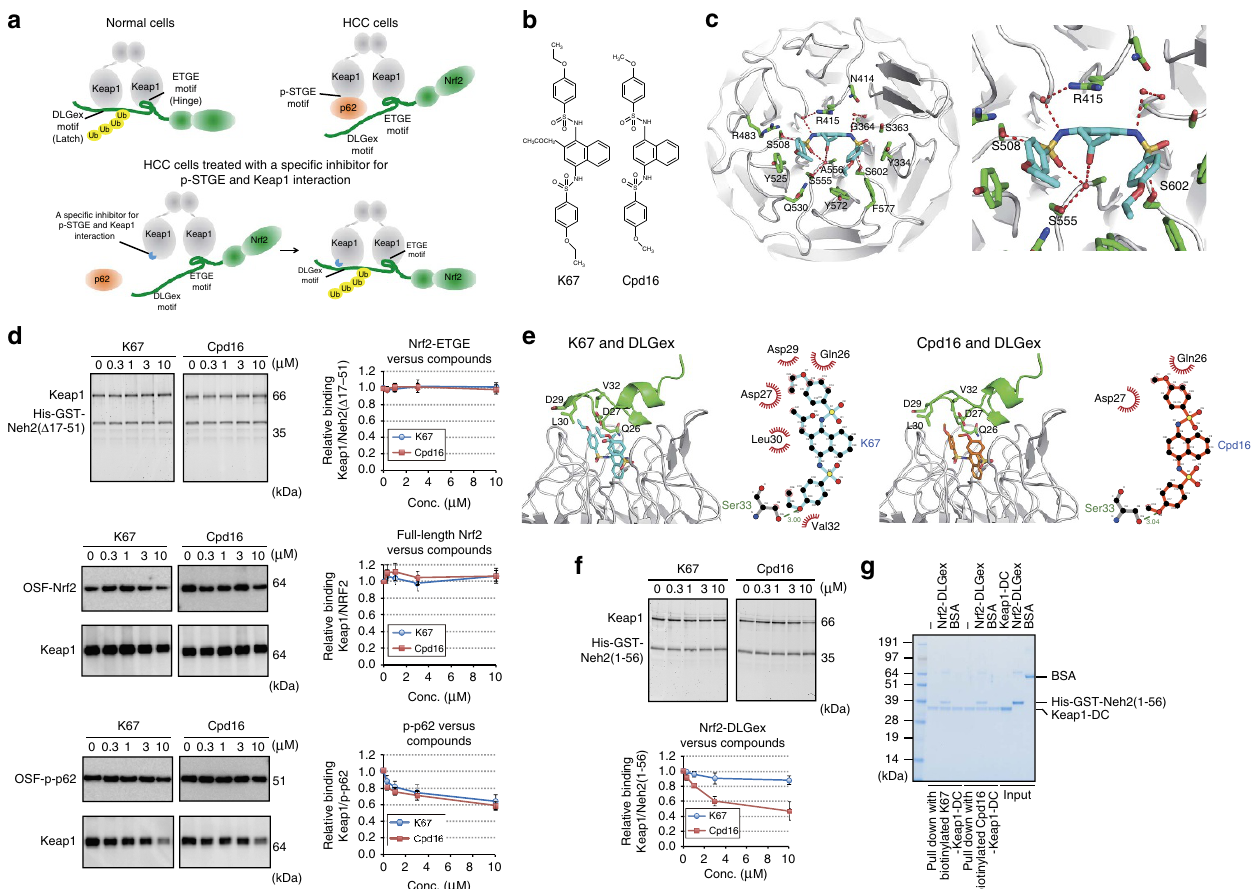
Figure 9 | K67, a chemical compound that inhibits the interaction between Keap1 and S349-phosphorylated p62. ( a ) Working hypothesis about an inhibitors of the interaction between Keap1 and S349-phosphorylated p62. ( b ) Structural formulas of K67 and Cpd16. ( c ) Crystal structure of Keap1-DC (white) in complex with K67 (cyan). Overall structure of Keap1-DC, shown as a ribbon model. K67 (cyan) and some of the potential interacting residues of Keap1-DC are shown in stick representation. A close-up view of K67 bound to Keap1-DC is shown. Intermolecular electrostatic interactions are depicted as broken red lines. ( d ) In vitro pull-down assay. Full-length Keap1 was allowed to form a complex with K67 (left panel) or Cdp16 (right panel) at the indicated concentration. Upper panel: Keap1 binding to His-GST-tagged Neh2( D 17-51) was estimated by Oriole fluorescent gel staining. Middle and bottom panels: Keap1 binding to OSF-p-p62 (middle panel) or OSF-Nrf2 (bottom panel) was estimated by immunoblot analysis with anti-Keap1 antibody. Data are representative of three independent experiments. ( e ) Modelling of Keap1 (white)–K67 (cyan)–DLGex (green; upper left panel) and Keap1–Cpd16 (orange)– DLGex (lower left panel). Upper right: schematic representation of the interface between DLGex and K67. Lower right: schematic representation of the interface between DLGex and Cpd16. Potential hydrogen bonds are indicated by dashed lines between the atoms involved, whereas hydrophobic contacts are represented by an arc with spokes radiating towards the ligand atoms they contact. ( f ) In vitro pull-down assay. Full-length Keap1 was allowed to form a complex with K67 (left panel) or Cdp16 (right panel) at the indicated concentration. Keap1 binding to His-GST-tagged Neh2(1-56) was estimated by Oriole fluorescent gel staining. Data are representative of three independent experiments. ( g ) In vitro pull-down assay with biotinylated compounds. His-GST-tagged Neh2(1-56) binding to the Keap1-DC complexed with biotinylated K67 or Cpd16 was estimated by Coomassie brilliant blue staining. Data are representative of three independent